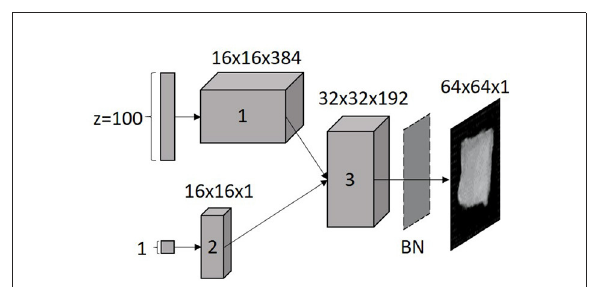
FIGURE3 Generator architecture. The noise vector z and the corresponding label were an input to the generator, z and label are then concatenated and transposed to the image size of the original data set (3); to make the generator more stable, a batch normalization (BN) is used; the numbers marked each